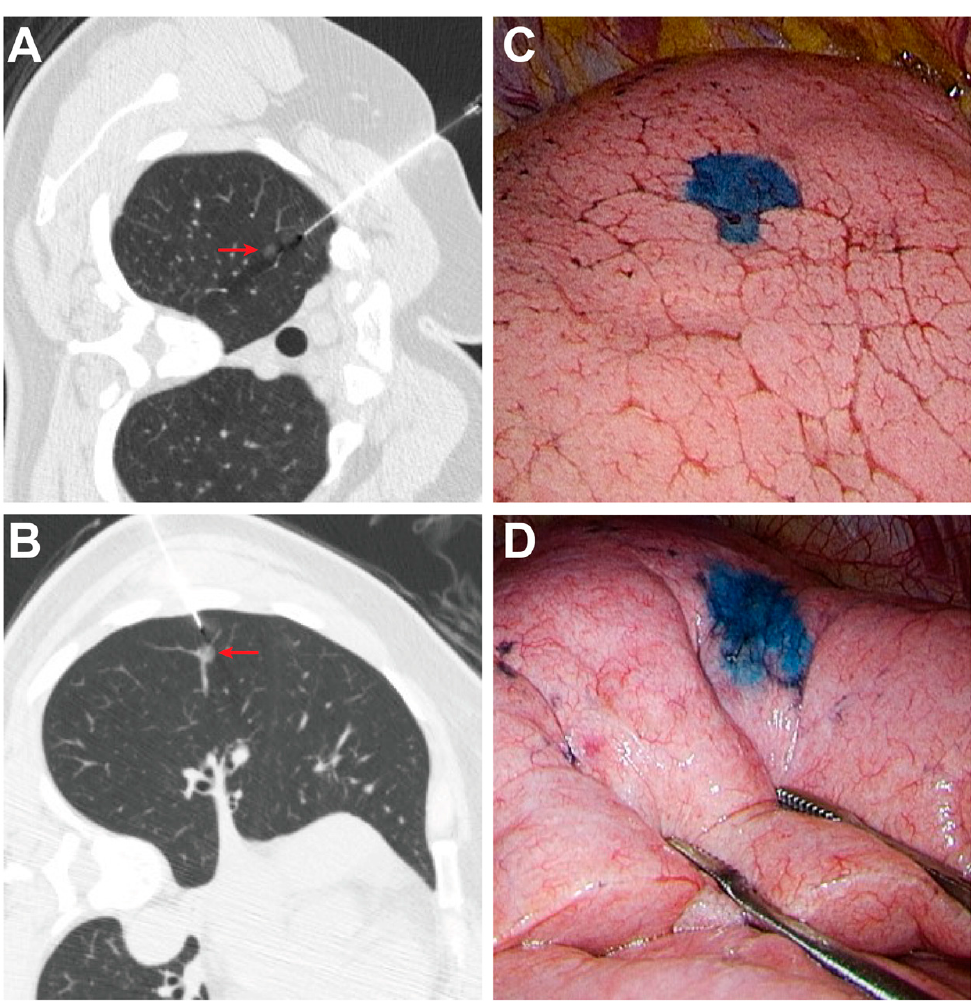
anatomy. For these patients, sublobar anatomic resection was performed. The median total radiation dose and procedure time differed significantly between the two groups (Table 2), with a lower median total radiation dose (2.7 vs. 3.5 mSv, p = 0.001) and shorter CT-guided localization procedure time in the simultaneous group (20.95 vs. 25.28 min, p = 0.001). There was no interoperator difference, with the two operators demonstrating shorter procedure times in the simultaneous group than in the sequential group (20.02 vs. 24.42 min, p = 0.006 and 22.98 vs. 25.75 min, p = 0.019). More cases were performed under lateral decubitus positions in the simultaneous group than the sequential group (12 [18.8%] vs. two [3.2%], p = 0.018). There was no significant difference in the distance between the dye and nodule, the distance between the chest wall and nodule, or incidence of procedure-related complications (including pneumothorax and pulmonary hemorrhage) Abbreviations: RUL, right upper lobe; RML, right middle lobe; RLL, right lower lobe; LUL, left between groups. No specific risk factors associated with procedure-related pneumothorax upper lobe; LLL, left lower lobe; IQR, interquartile range. were identified by univariate logistic regression analysis (Table 3).